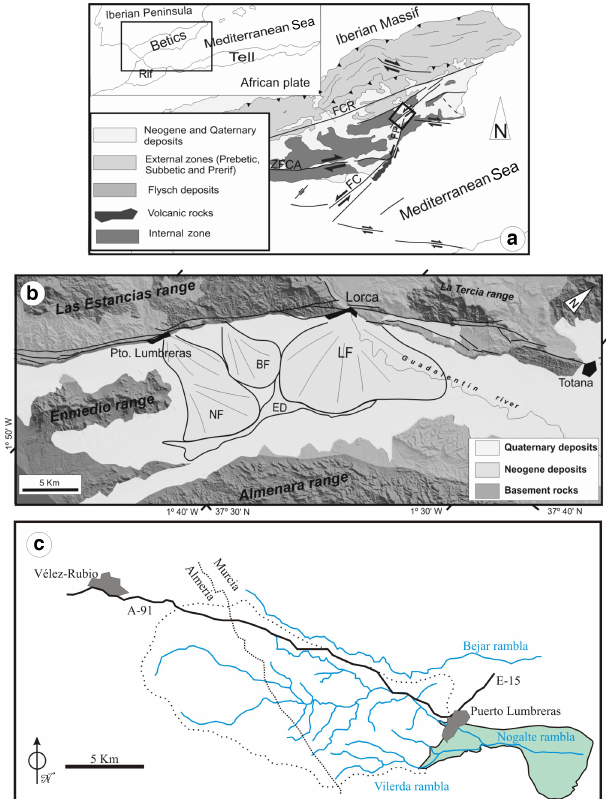
Figure 1. (a) Geological setting of the study area. The black square shows the location of the Guadalentín valley into the Eastern Betic Cordillera. (b) Schematic geological map showing the western part of the Guadalentín Upper Depression and the three main allu- vial fans, LF: Lorca fan, BF: Béjar fan and NF: Nogalte fan. ED: endorheic deposits (lacustrine and fluvio-palustrine